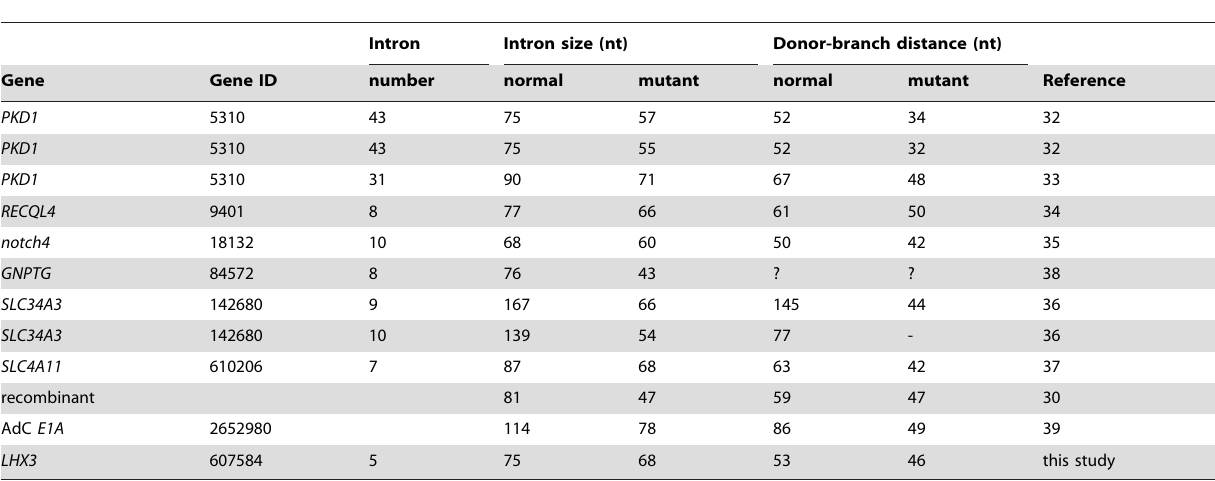
?=no clear branch site. -=no branch site.